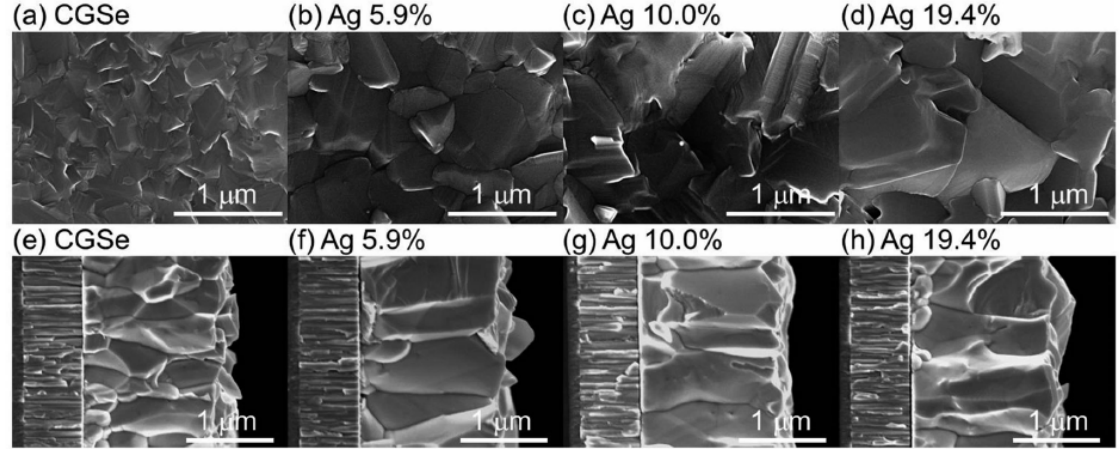
Figure 3. Top and cross-sectional views of CuGaSe 2 ( a ), ( e ), and Ag x Cu 1 − x GaSe 2 films with x = 5.9% ( b ), ( f ), 10.0% ( c ), ( g ), 19.4% ( d ), ( h ). Reproduced from Reference [45]